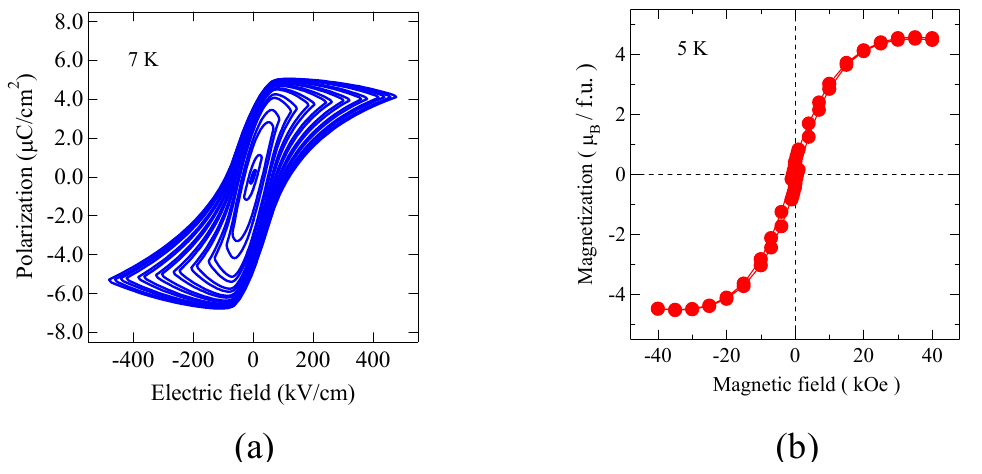
NiMnO thin film grown on 2 6